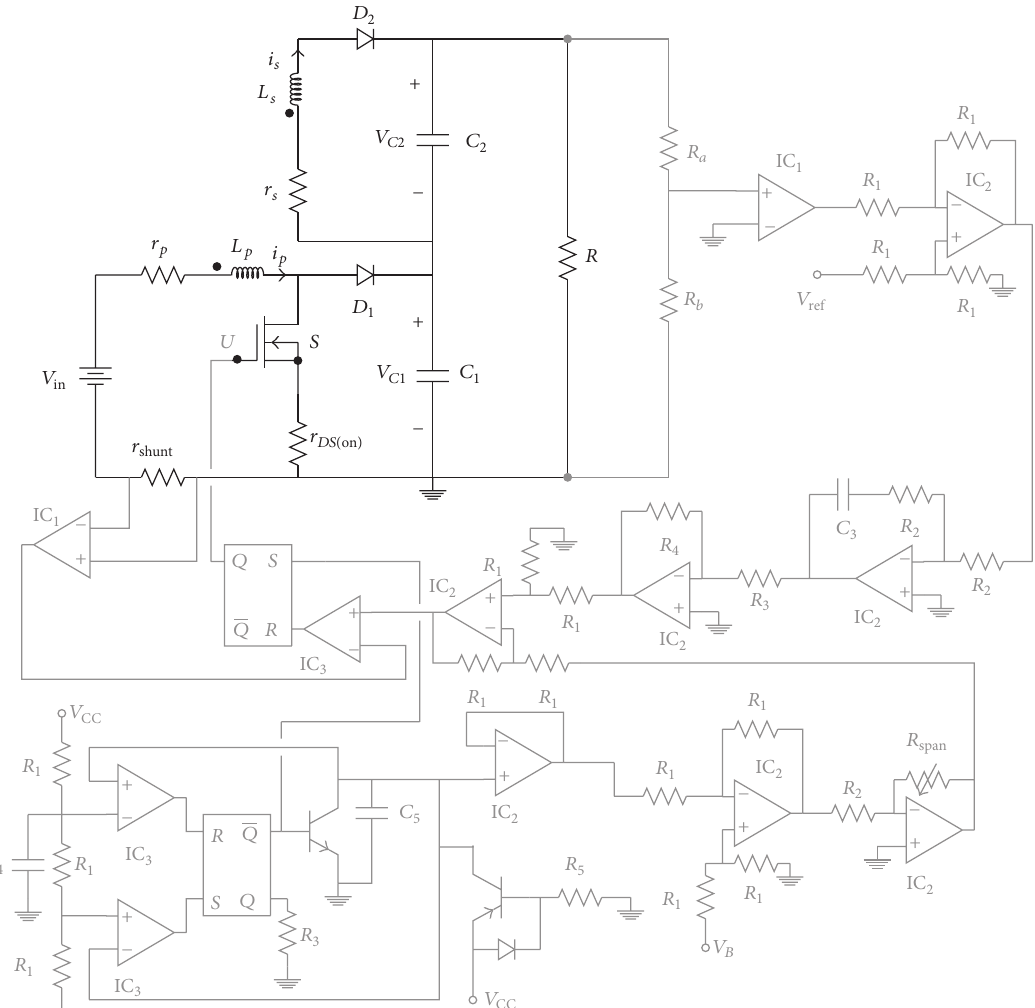
Figure 9: Circuit diagram of the experimental